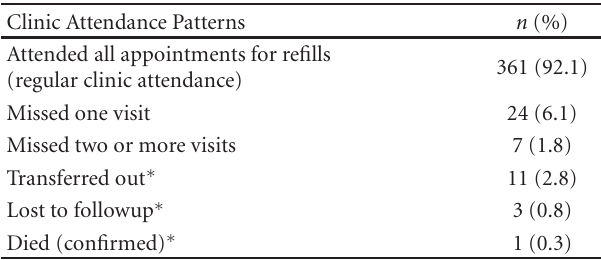
Table 2: Summary of clients’ clinic attendance during study period ( N =